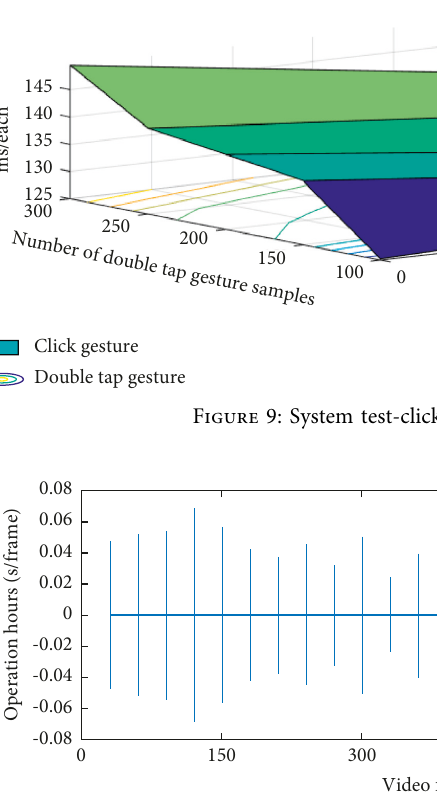
Figure 10: Kinect imaging extraction and computational performance